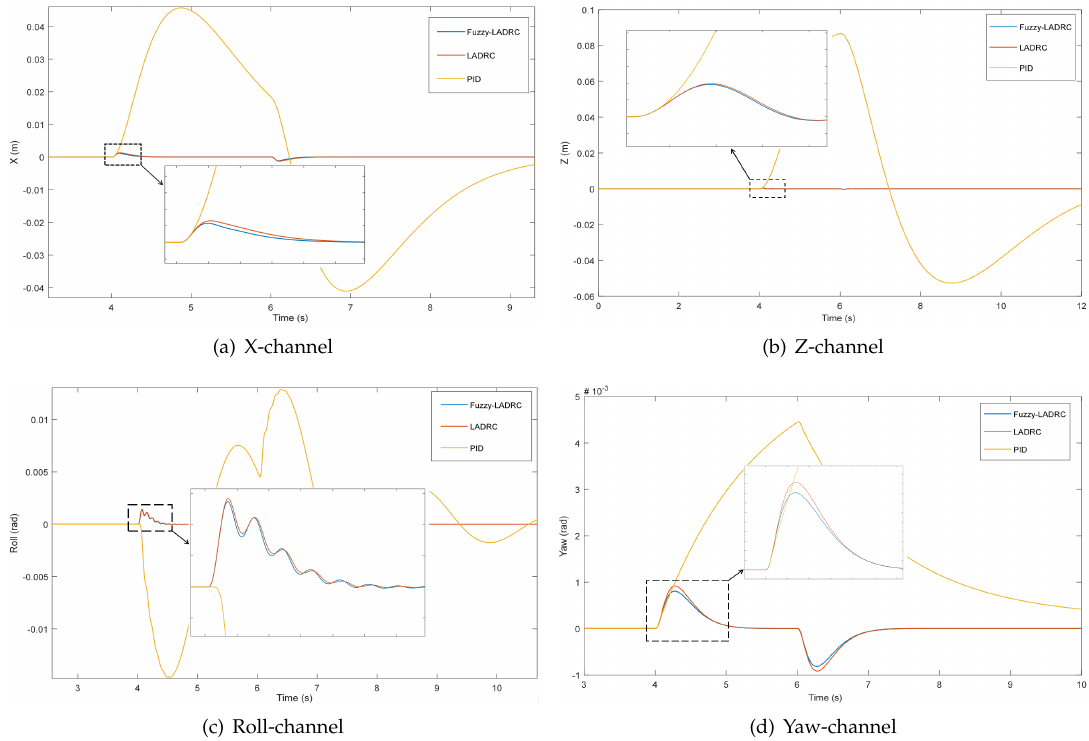
Figure 14. Experimental results of disturbance